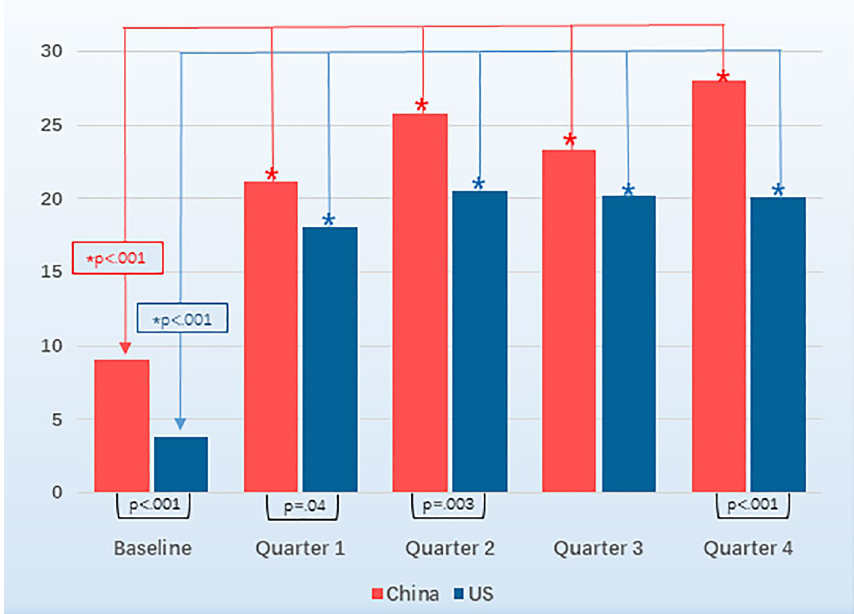
Figure 1. Depression Rates of Residents in China (red) and the United States (blue). The PHQ depression rates of residents in each quarter is significantly higher than the baseline in both countries.